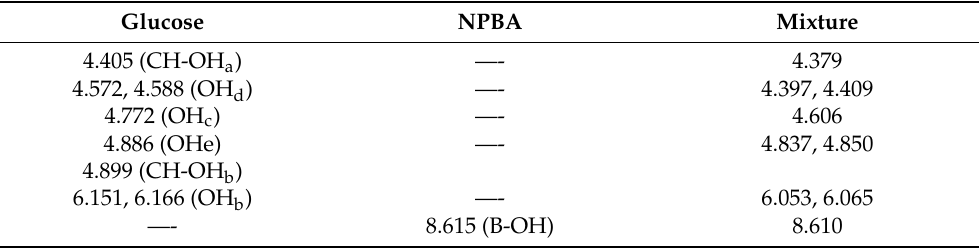
Table 2. 1 H-NMR chemical shift of glucose, the ionophore NPBA, and their mixture in deuterated DMSO [39,40]. Glucose NPBA Mixture